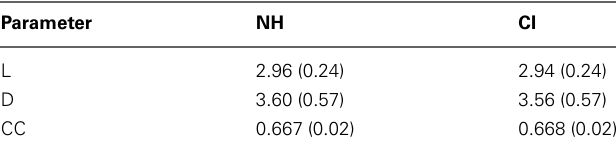
Table 4 | Summary of results of bootstrapped partial word matched correlation networks analysis.